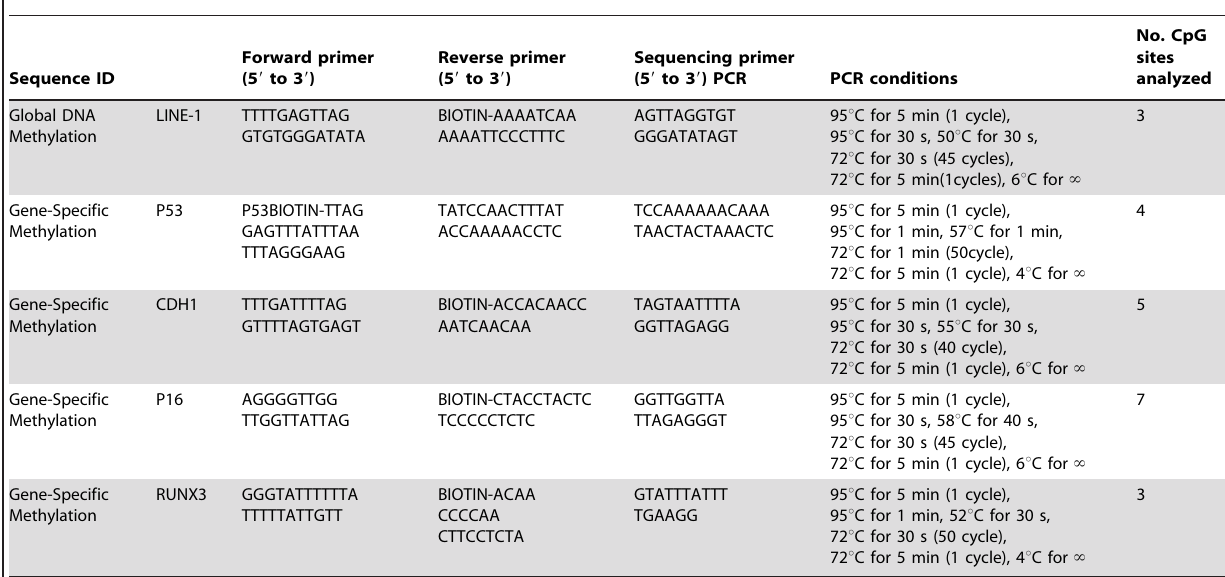
Table 1. Primer sequences and PCR conditions for global DNA methylation and specific gene methylation.